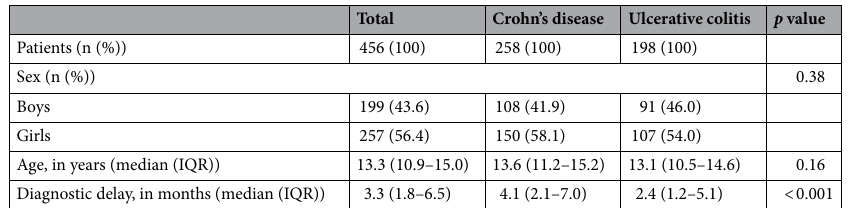
Total Crohn’s disease Ulcerative colitis p value Patients (n (%)) 456